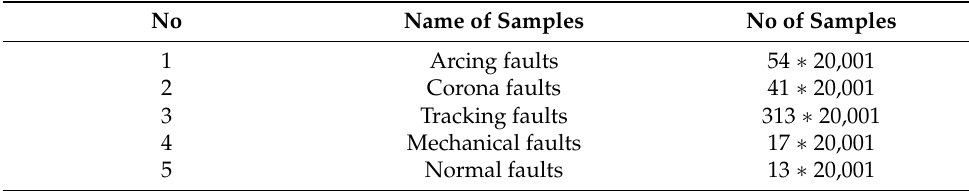
Table 2. The datasets sample corona and non-corona in the time domain .